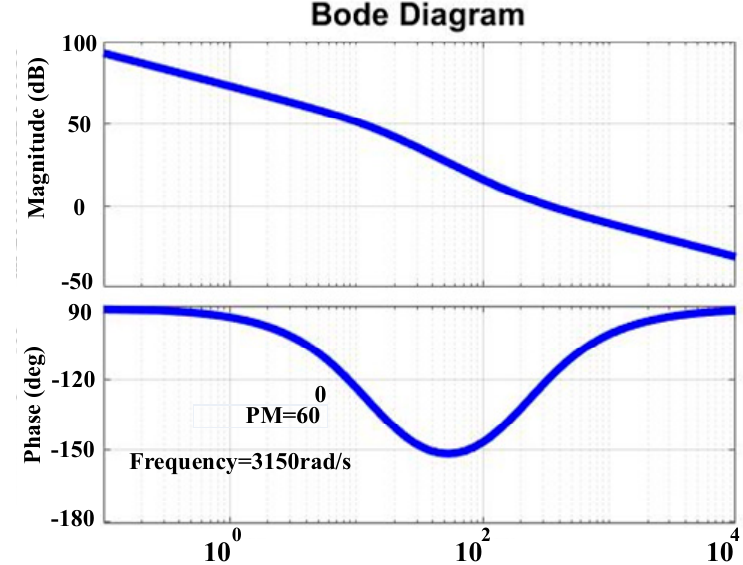
Figure 12. Bode plot of the compensated voltage control loop system: PM = 60° at 3150 rad/s (500 Hz).